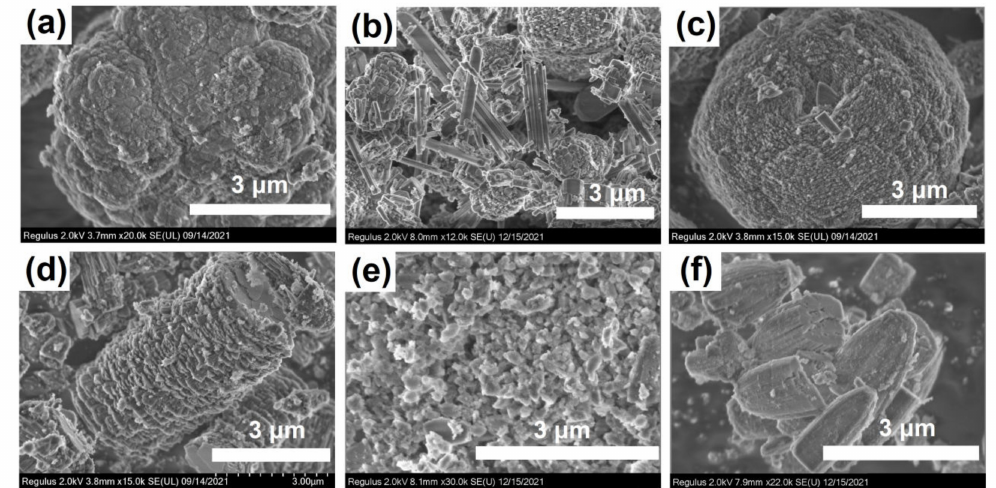
Figure 8. SEM image of crystallization products based on silicoaluminophosphate gels: ( a ) Sample SAPO-11-PB-1.0; ( b ) Sample-SAPO-11-PB-1.5; ( c ) Sample-SAPO-11-iAl-1.0; ( d ) Sample-SAPO-11-iAl- 1.5; ( e ) Sample-SAPO-11-PB-1.0(90); ( f )